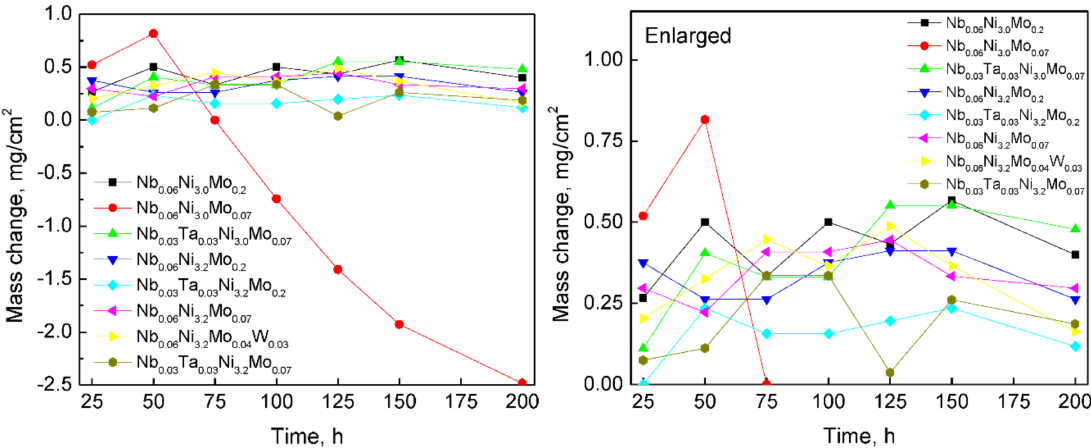
Figure 8. The mass change of designed series-2 alloys after being oxidized in air at 800 ◦ C for up to 200